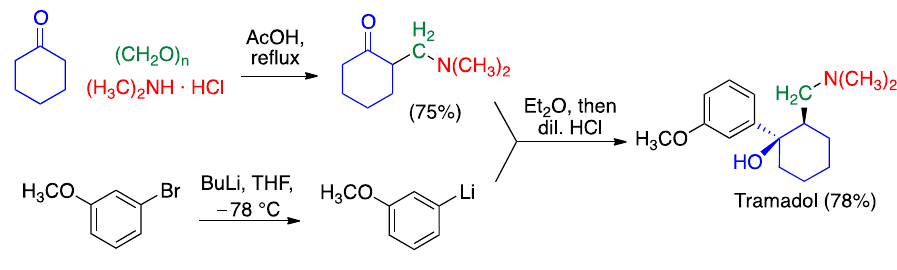
Figure 1. Some drugs that are synthesised using a Mannich reaction as the key step. The bond thus created is marked in red.